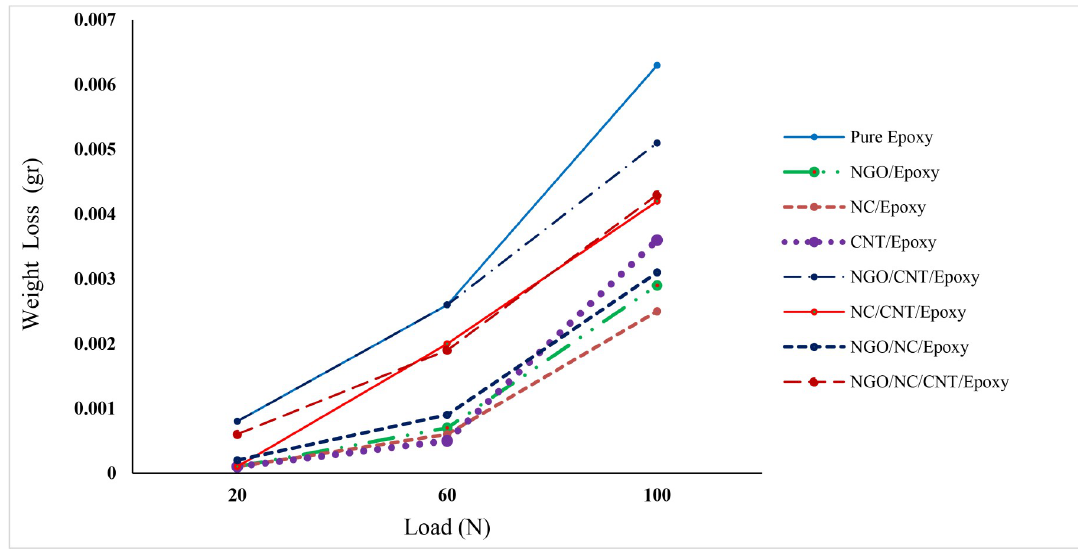
Fig 2. Weight loss of the studied materials in different applied